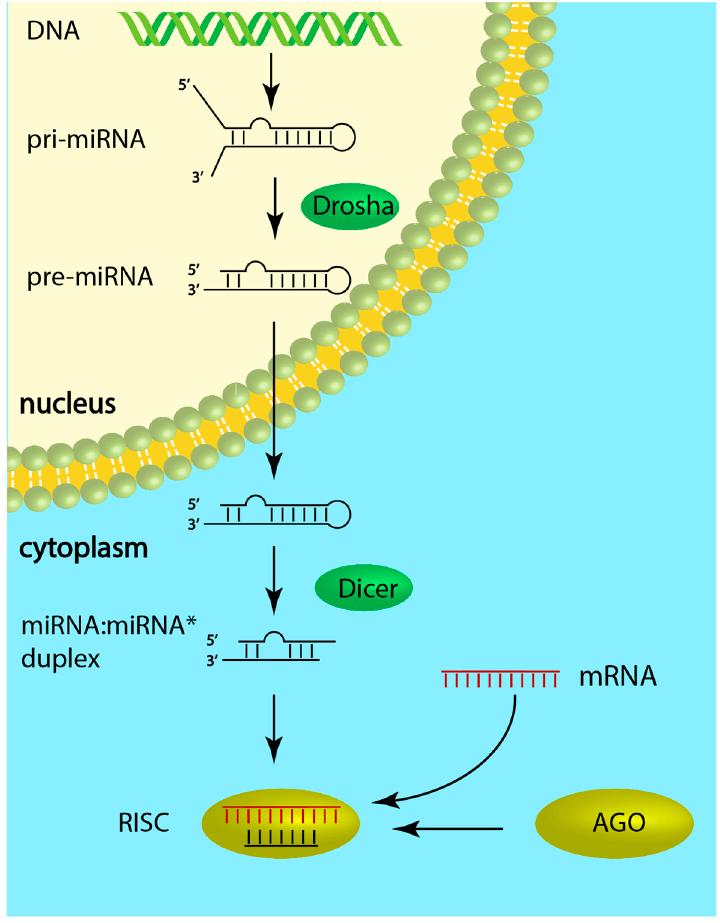
Figure 1. MicroRNA biogenesis . First the microRNA (miRNA) gene is transcribed to create the pri- miRNA, a single-stranded RNA hairpin with imperfect base pairing. Then, Drosha will cleave the pri- miRNA into a 70-nucleotide hairpin with a 2-nucleotide-3 ′ overhang, the pre-miRNA. After export to the cytoplasm, Dicer will further process the molecule and form a double-stranded miRNA:miRNA* duplex 22 nucleotides long. One strand of this duplex, called the guide strand, combines with the Argonaute (AGO) protein and the target messenger RNA into the RNA-induced silencing complex (RISC). The other strand, the passenger strand, is degraded.